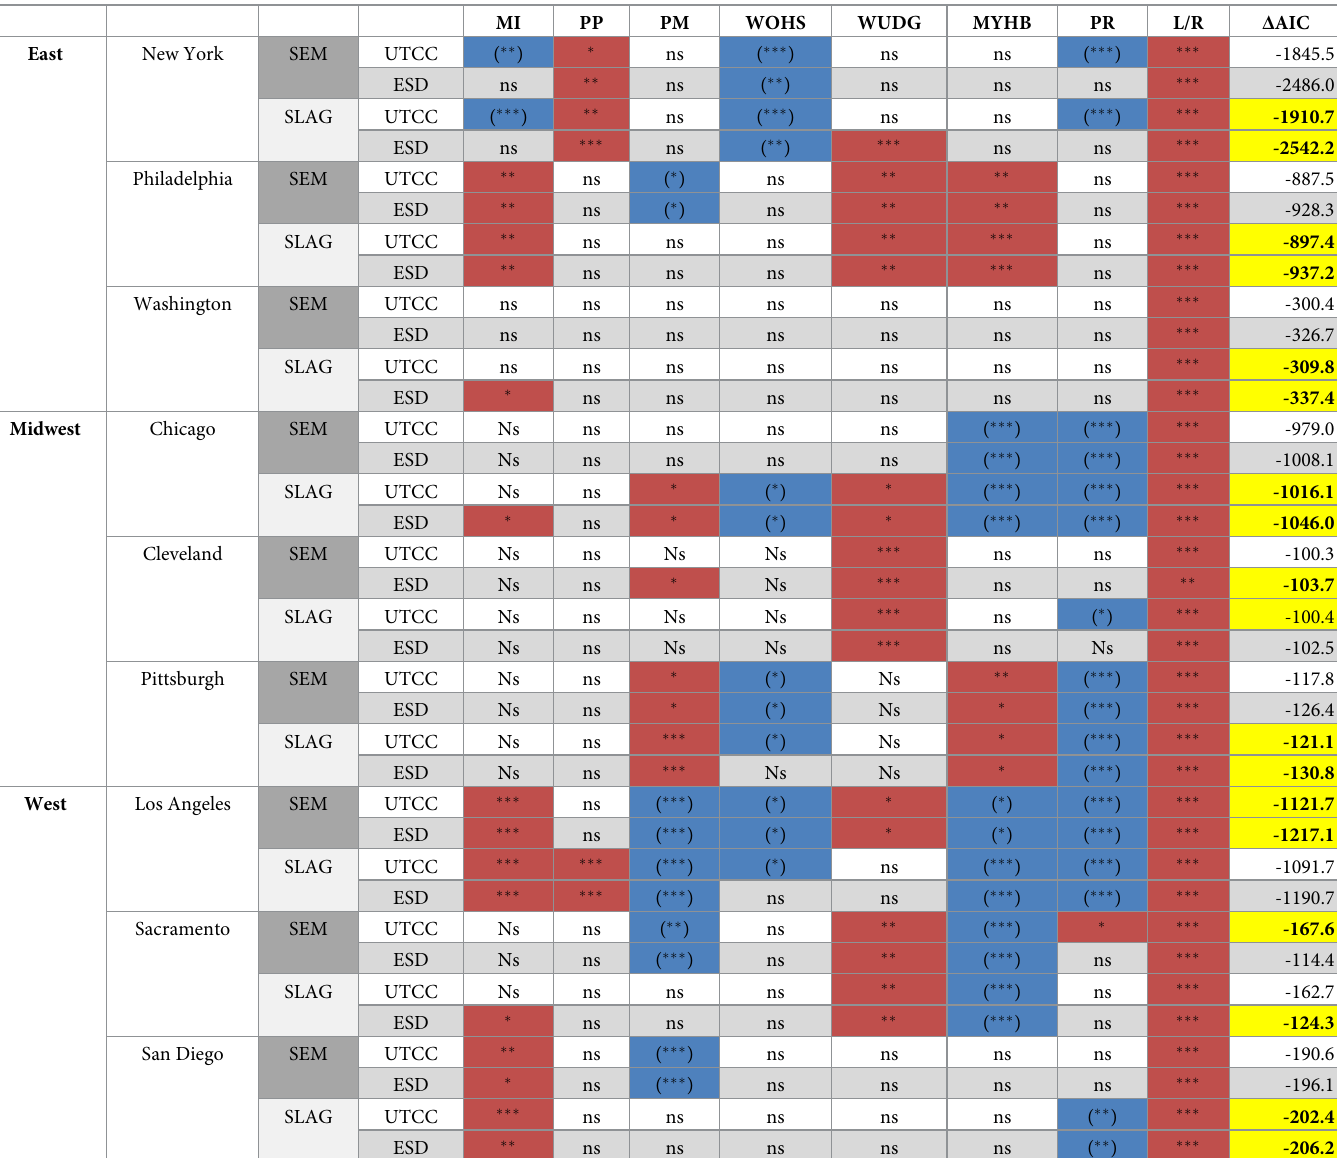
Table 5. Spatial autoregressive (SAR) model results using urban tree canopy cover (UTCC) and ecosystem service dollars (ESD) as response